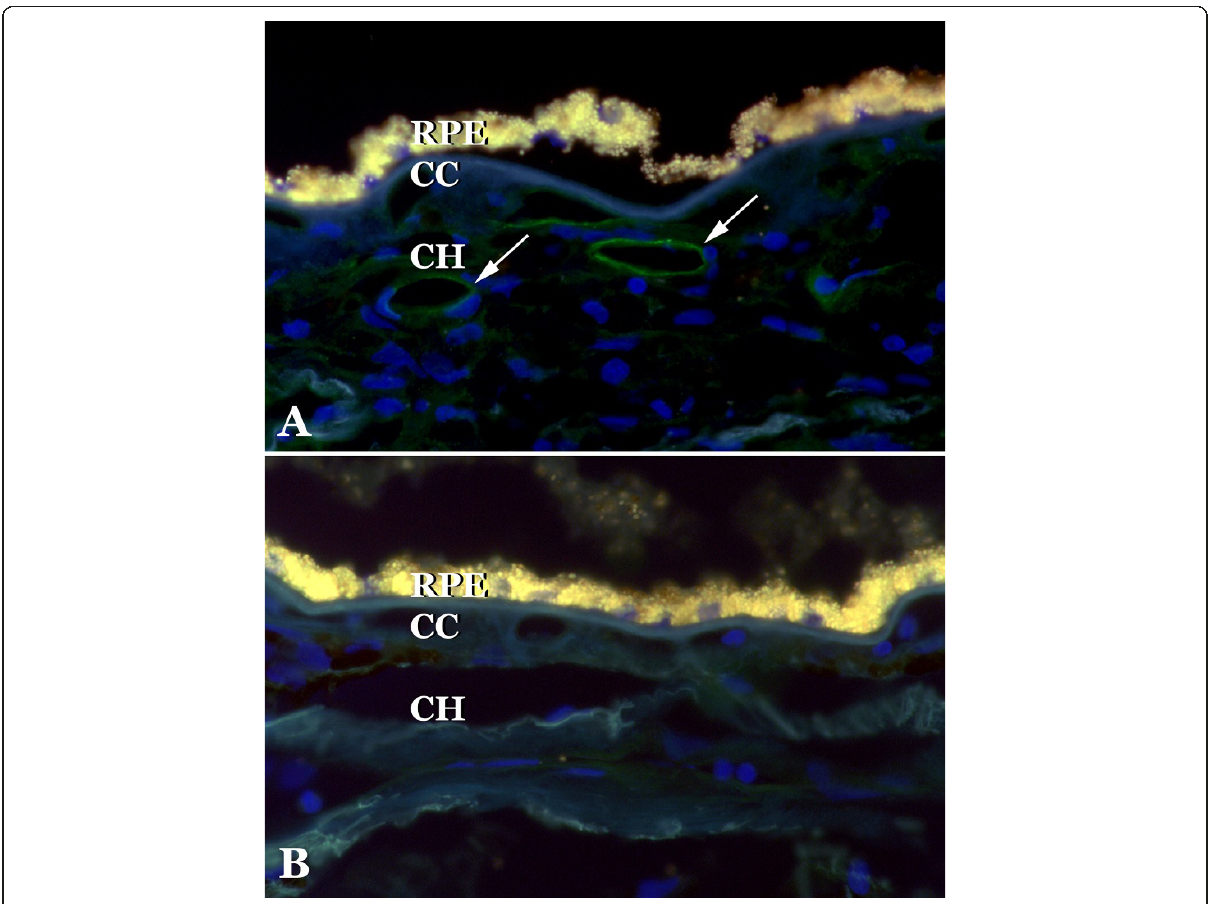
Figure 2 Localization of P-selectin to choroidal vessels . The endothelium of large choroidal vascular elements in Sattler ’ s and Haller ’ s layers of the choroid showed immunoreactivity with antibodies directed against P-selectin (A). Modest labeling is observed in the choriocapillaris. Labeling was not observed when the primary antibody was omitted (B). RPE, retinal pigment epithelium; CC, choriocapillaris; CH, outer choroid.